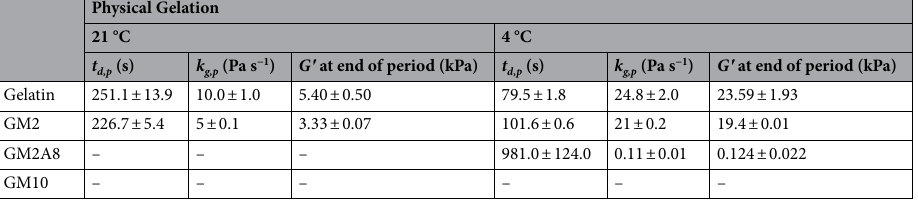
Fig. 4. The parameters describing the initial increase of G ′ ( k g,c ) as well as the initial increase of DBC ( k DBC ) were calculated with the G ′ ( t ) and DBC ( t ) curves, respectively (Table 3), similarly to how it was described above for k g,p . Additionally, extracted reaction rates of double bond conversion are shown in Figure S5. The baseline for calculation of k DBC was set to zero for cross-linking at 37 °C, or to the final G ′ of the physical gel for sequential cross-linking procedure (20 min at 21 °C and 40 min at 4 °C). Furthermore, the chemical gelation delay time ( t d,c ), measured from the start of UV-irradiation, and the final DBCs in mmol g −1 are given in the Supporting Information (Table S1 for the classical method, Table S2 for sequential cross-linking). The DBC increased rapidly for all derivatives and cross-linking conditions directly after starting UV irradia- tion, G ′ increased slightly delayed, compare Fig. 4A and Fig. 4B as well as Fig. 4C and Fig. 4D, respectively. At 37 °C, the DBC rates k DBC were indistinguishable for GM2 and GM2A8 ( p > 0.05), while k DBC of GM10 was roughly 9.5 times as high when expressed as amount of converted double bonds per second. The k DBC was generally lower for sequential cross-linking than for the classical method, but relative differences between the derivatives were similar in both cross-linking conditions. The results showed that both, increasing DM as well as elevated temperature, accelerated the absolute DBC kinetics (Figure S5 and Figure S6). These findings were expected and gave the following order DBC kinetics: GM10 > GM2A8 > GM2, following the order of DM of the derivatives. However, interestingly there was no clear correlation between k DBC and k g,c of G ′ (Figure S6), especially because of exceptionally low k g,c of GM2A8. At both cross-linking conditions, k g,c decreased in the order of GM10 > GM2 ≫ GM2A8 and the resulting G ′ were significantly higher for all gelatin derivatives in the sequential cross-linking protocol when UV irradiation was carried out at 4 °C ( p < 0.001). A similar observation was already